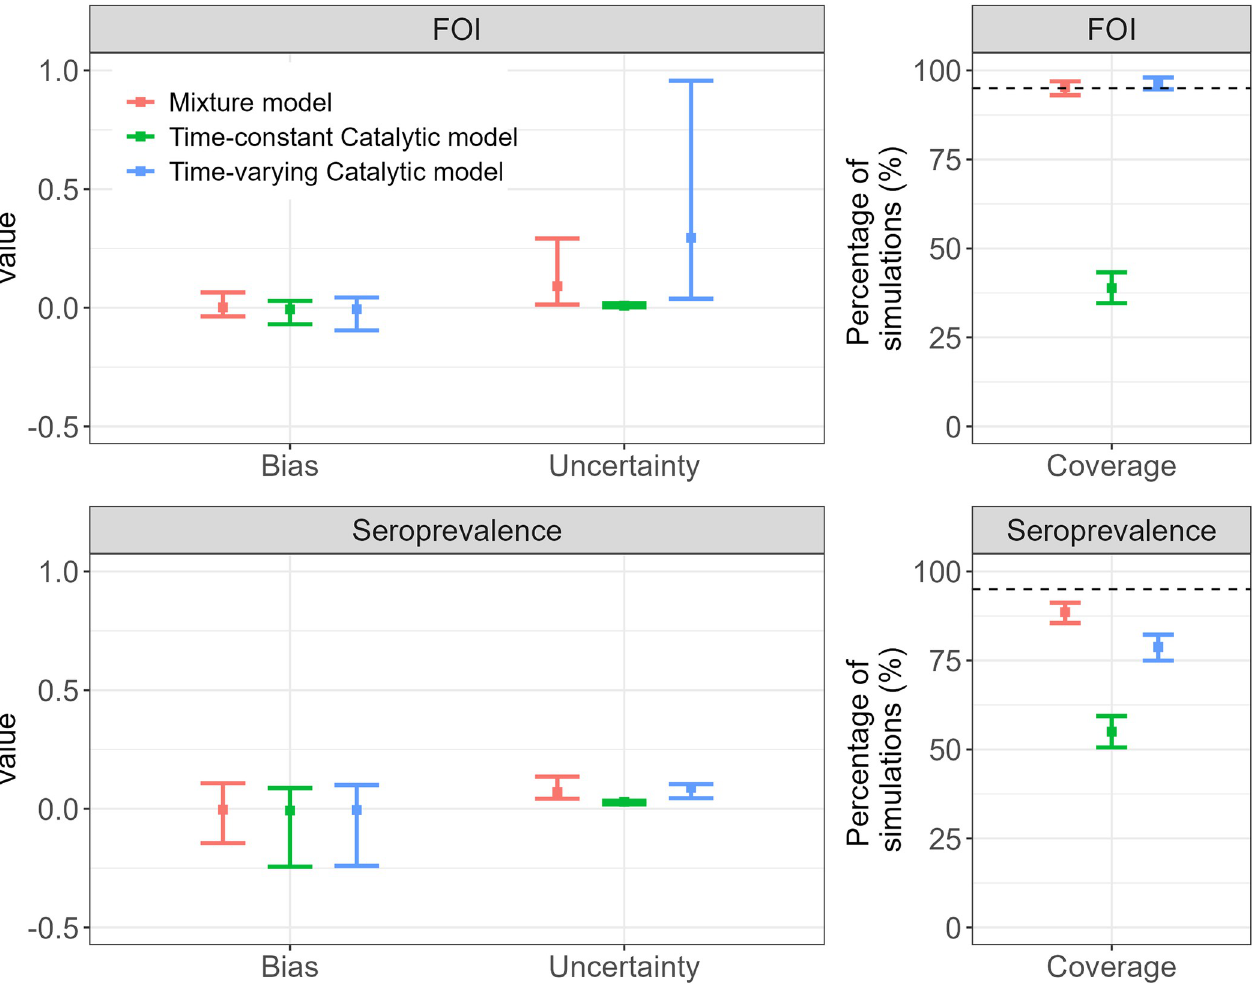
Fig 1. Bias, coverage, and degree of uncertainty for seroprevalence and force of infection (FOI) estimates using catalytic and mixture models fitted to simulated datasets (Dataset C). Bias is calculated as the estimated parameter value minus the true parameter value. Uncertainty is the width of the 95% Confidence intervals (CIs) around the central estimates, calculated using the bootstrap method. The coverage is the percentage of simulations where the estimated CIs contained the true values. The dashed line at 95% shows the threshold for the ideal coverage. For the bias and the uncertainty, the mean and 95% CI across the 509 simulations are given. For the coverage, the 95% exact binomial CI are